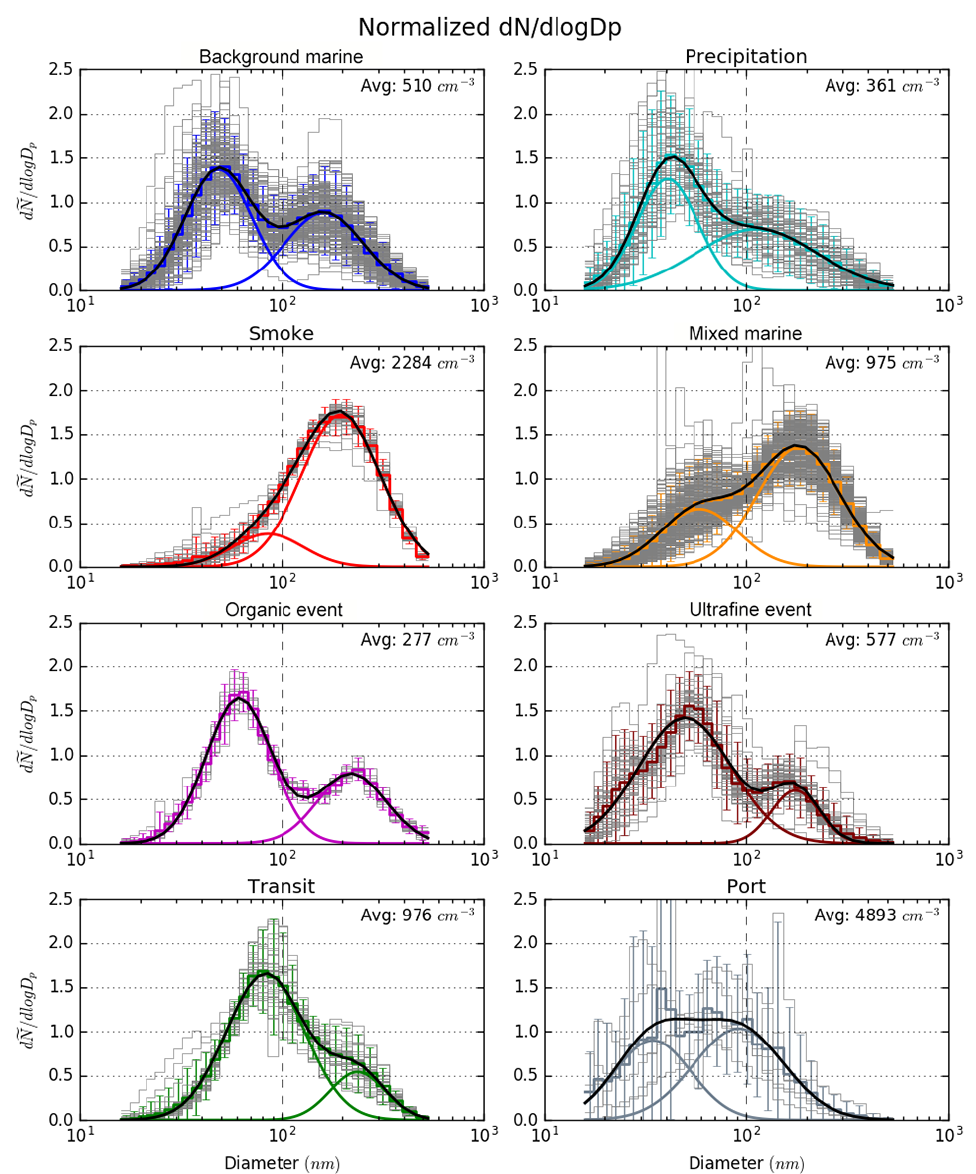
Figure 4. Normalized d N/ dlog D p particle size distributions for each spectrum within identified aerosol population types (grey), the associ- ated average bin values with error bars at 95% confidence interval (colored step lines; 1.96 × bin standard deviation), and best-fit lognormal modes (colored curves) with bimodal fit (black). The average particle number concentrations of data points within each population type are